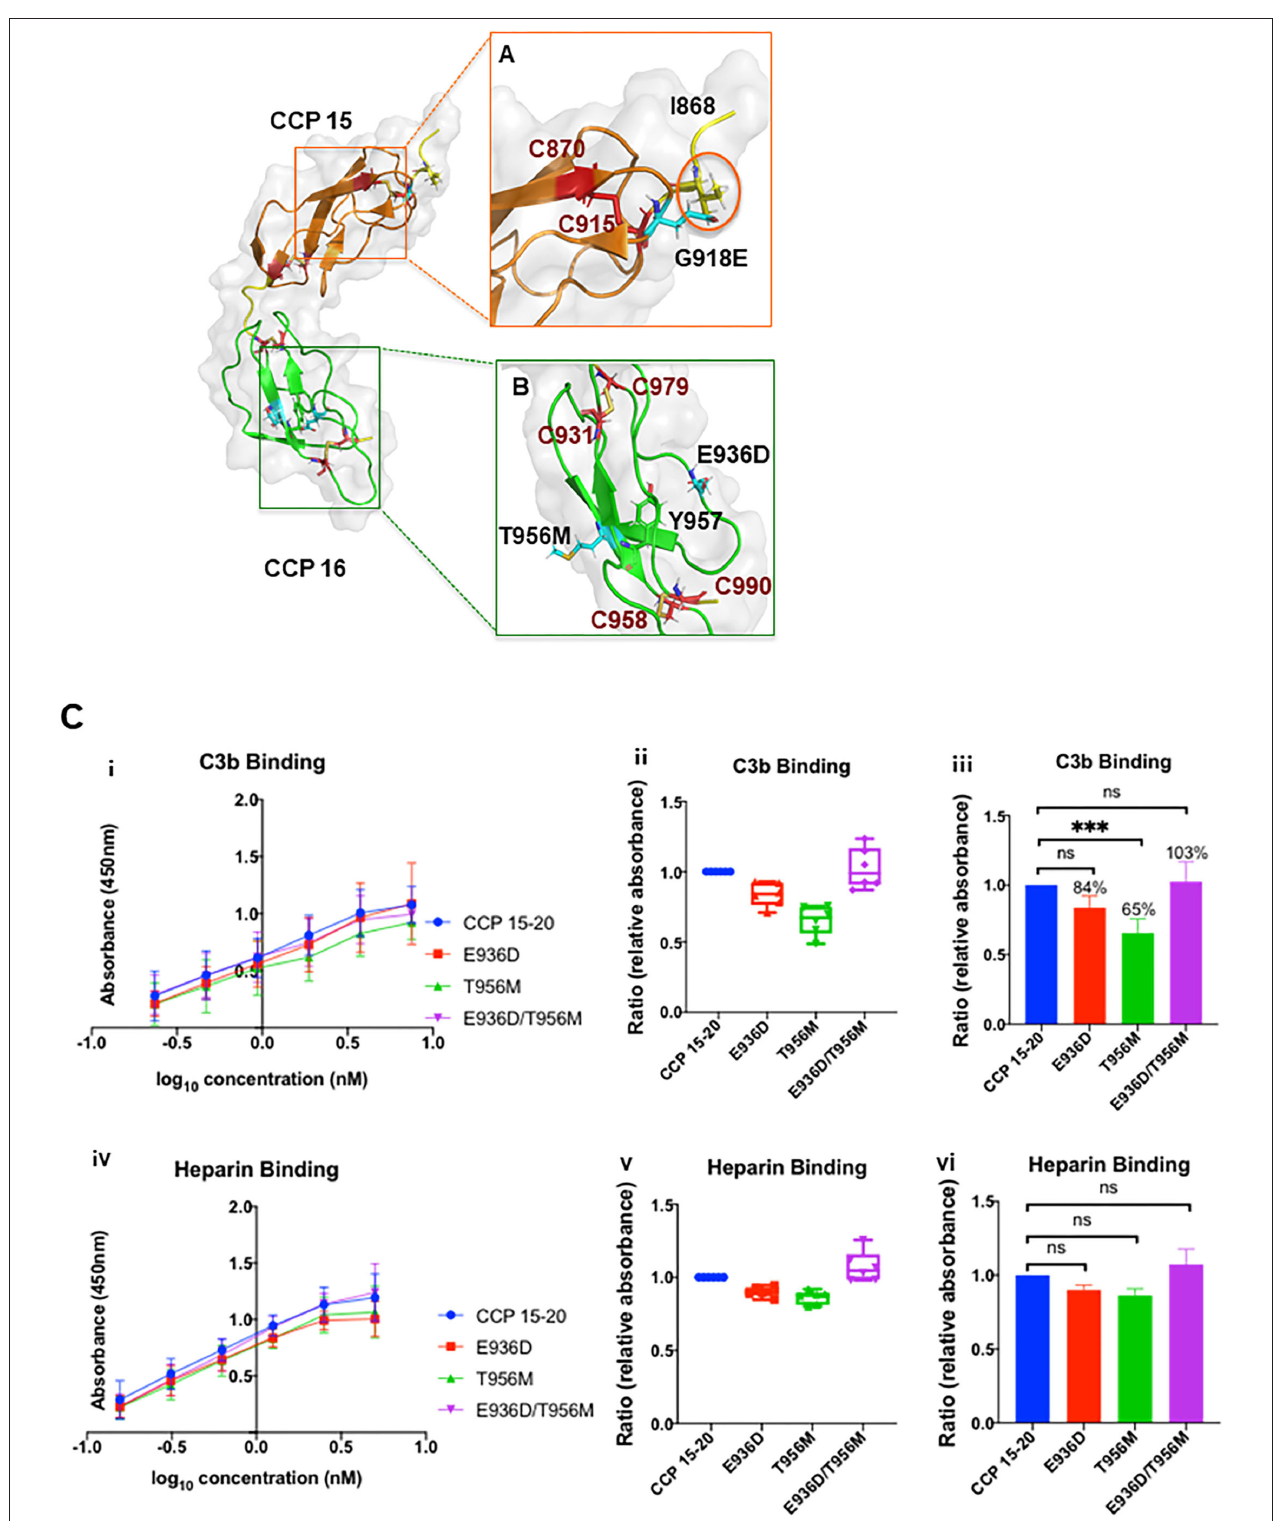
FIGURE 5 | Structural analysis of G918E, E936D, and T956M. Nuclear magnetic resonance spectroscopy solution structure of CCP 15–16 (PDB ID: 1HFH) (32). (A) The highest frequency rotamer of the G918E side chain and its clashing residue I868 is highlighted in the orange circle. (B) The highest frequency rotamer of